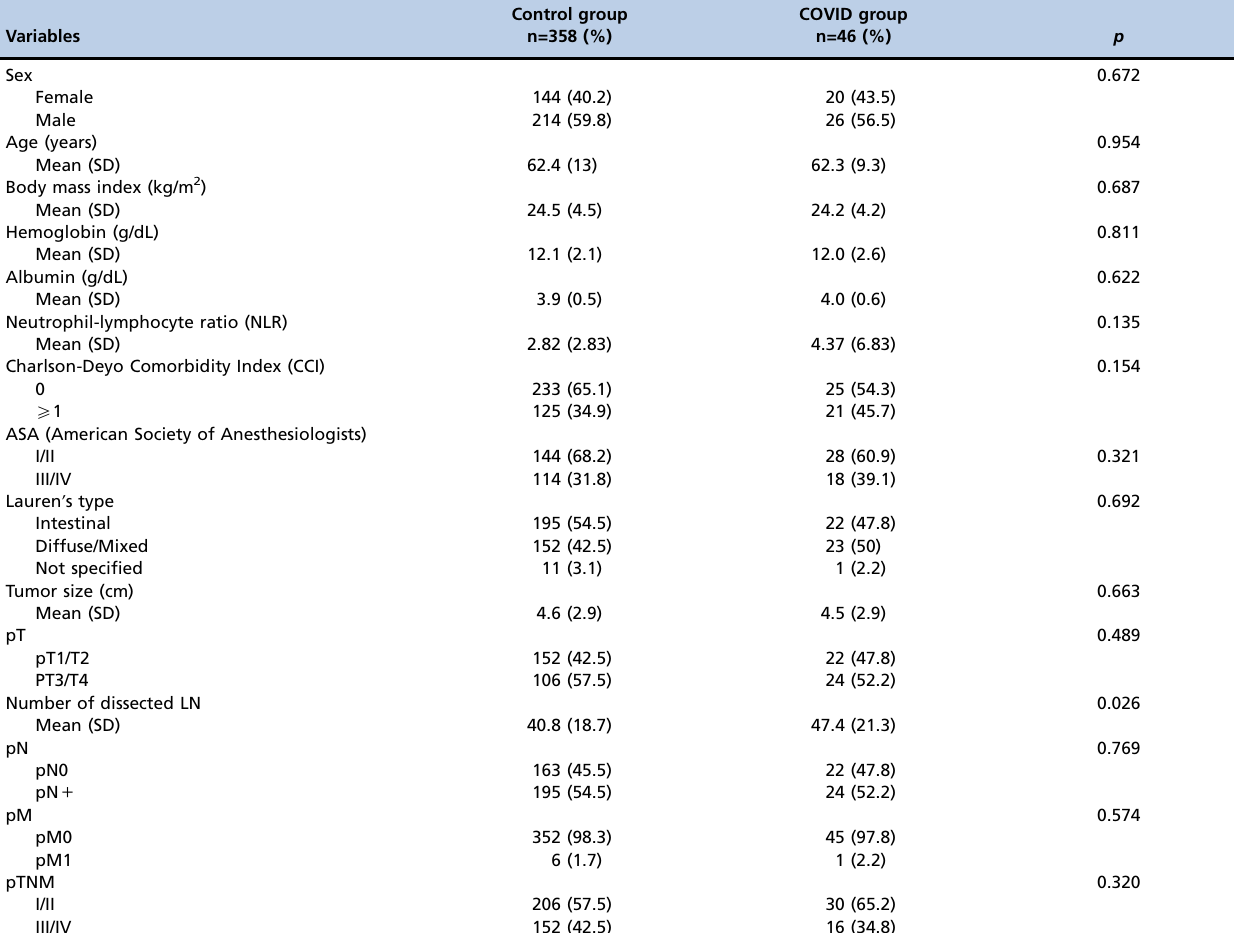
Table 2 - Clinicopathological characteristics of patients with curative GC according to the groups.